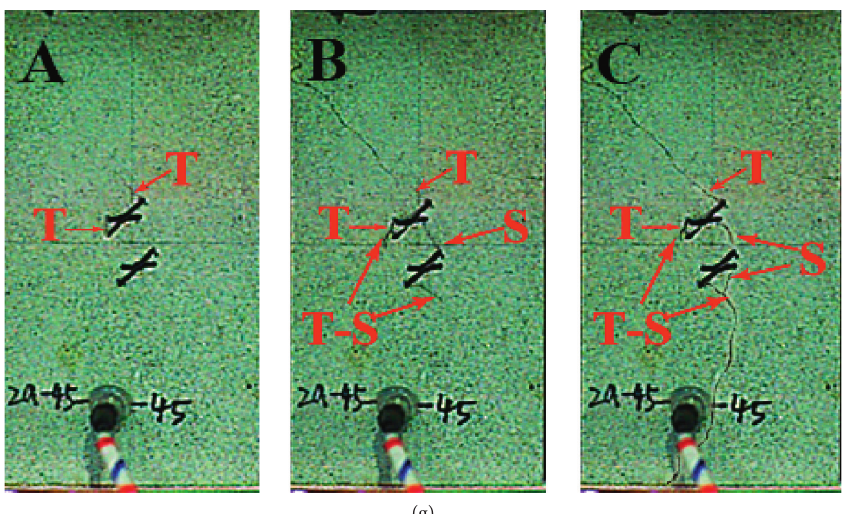
Figure 5: Crack propagation in specimens for different dips of the rock bridge with main flaw ((T) tensile crack, (S) shear crack, and (T-S) mixed tensile-shear crack). (a) β � − 60 ° . (b) β � − 30 ° . (c) β � 0 ° . (d) β � 30 ° . (e) β � 60 ° . (f) β � 90 ° . (g) β � 120 °